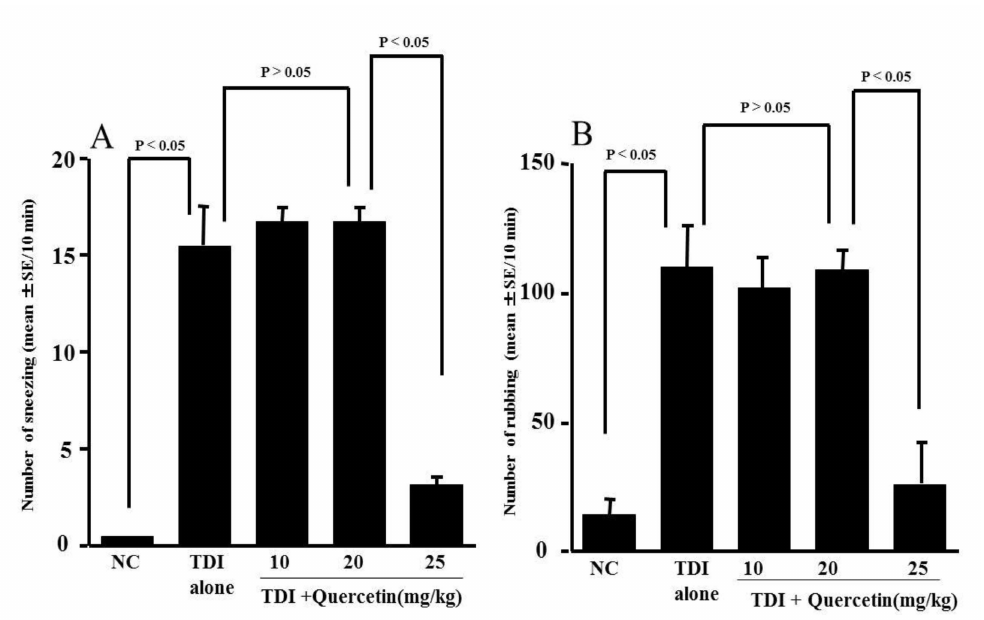
Figure 3. Influence of quercetin on the increase in sneezing ( A ) and nasal rubbing ( B ) by toluene 2.4-diisocyanate (TDI) nasal instillation in sensitised rats. TDI-sensitised rats were treated orally with various doses of quercetin for five days before TDI provocation. The number of sneezing and rubbing movements were counted for 10 min just after the TDI nasal challenge. The data are expressed as the mean ± SE of five